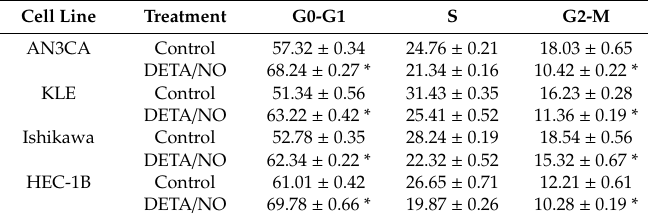
Table 1. E ff ect of DETA / NO on cell cycle arrest.